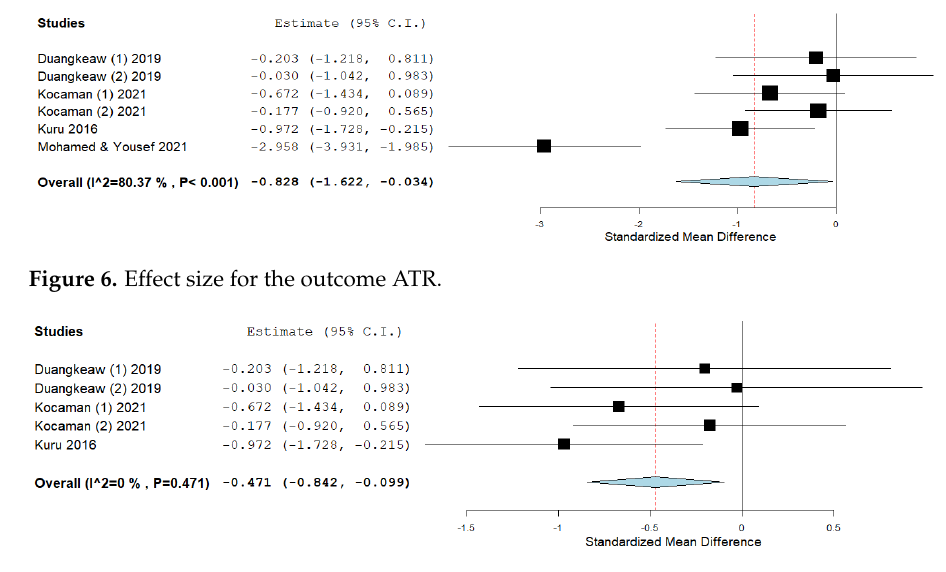
Figure 7. Effect size for the outcome ATR, without the study by Mohamed and Yousef [44].